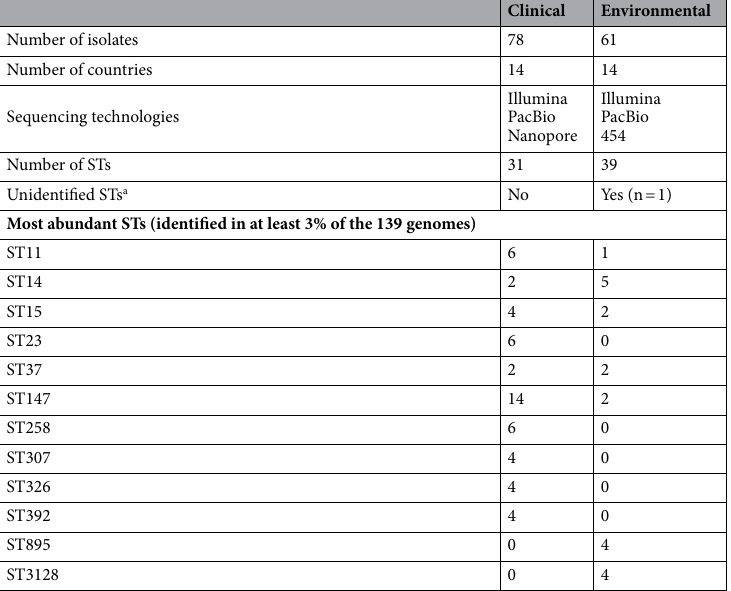
Table 1. Summary of the Klebisella spp. genomes features used in this study. a Unidentified ST refers to a ST which has not been determined as it has not been possible to obtain the housekeeping gene sequences required for this